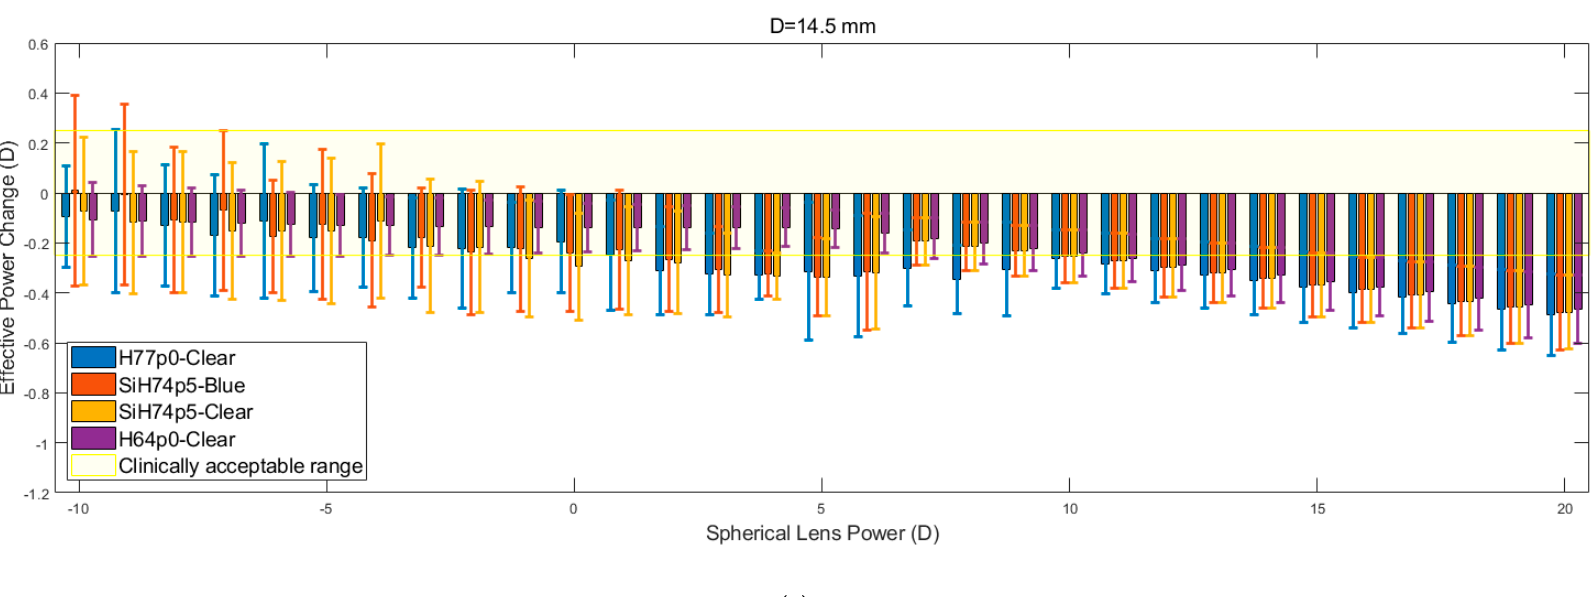
Figure 8. Effective power changes in spherical lenses for each of the four hydrogel materials. Results are presented for lens diameters D of 13.5 mm ( a ), 14.0 mm ( b ), and 14.5 mm ( c ).